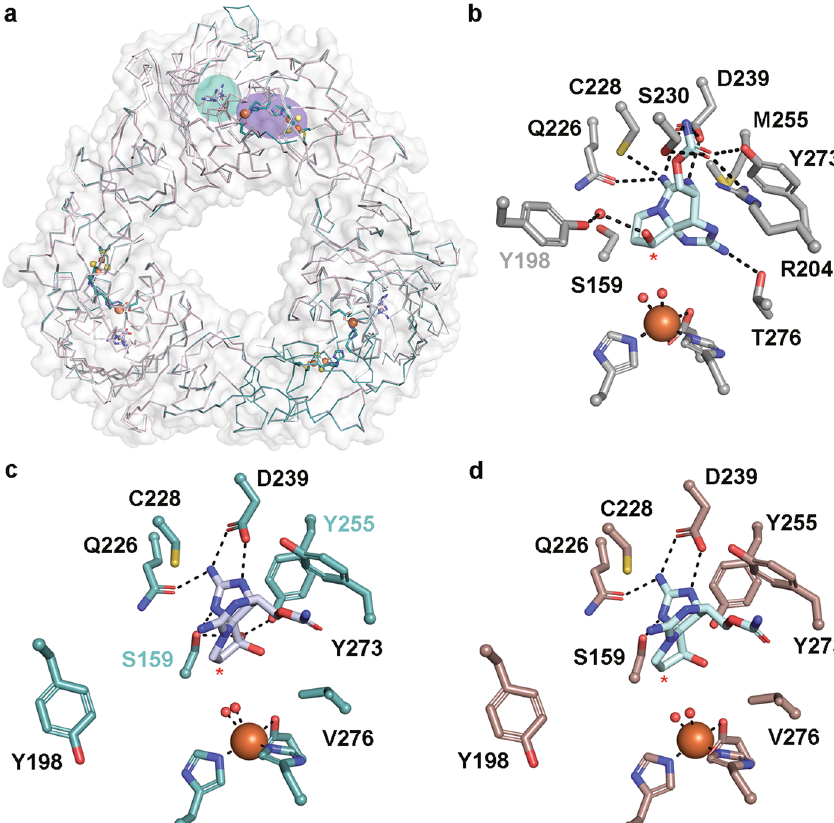
Fig. 2 The structures of SxtT and GxtA with their native hydroxylated substrates bound reveal the essential active site interactions. a The quaternary trimeric architectures of each determined structure are shown as ribbon diagrams and overlaid with each other (SxtT with β -STOH bound is shown in gray, GxtA with β -STOH bound is shown in pink, and GxtA with STX bound is shown in teal). The metallocenters that bridge two subunits are highlighted in purple and the substrate-binding site of one subunit is highlighted in teal. b The structure of SxtT with β -STOH bound reveals the myriad of interactions that this molecule forms in the active site. Tyr198 (gray font) interacts with the β -hydroxyl group of β -STOH via a water molecule. c STX binds in the active site of GxtA. The α -hydroxyl group interacts with active site residues Ser159 and Tyr255 (cyan font). d Despite the similar makeup of the GxtA active site relative to SxtT, β -STOH binds in a remarkably different orientation and interacts with conserved residues Gln226 and Asp239. In all panels, the position of hydroxylation is marked with a red